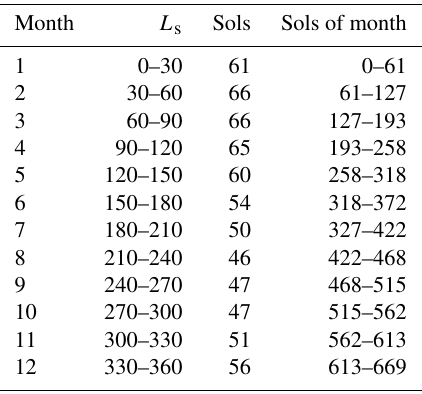
Table A3. Dust refractive index used, as described in Balkanski et al.